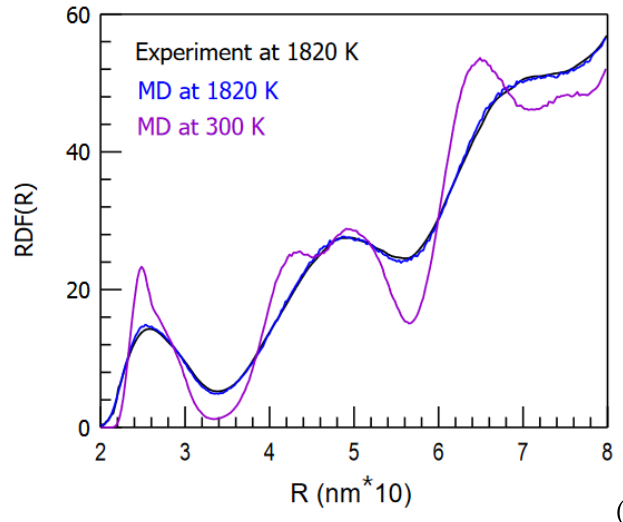
Figure 1. Density changes on heating and cooling of Cu and Fe as a function temperature ( a ). Reproduced from [36] with permission of MDPI. RDFs of Fe in liquid at 1820 K (experiment and MD simulation) and glassy at 300 K (MD simulation only) state ( b ). The experimental RDF curve is taken from [37].